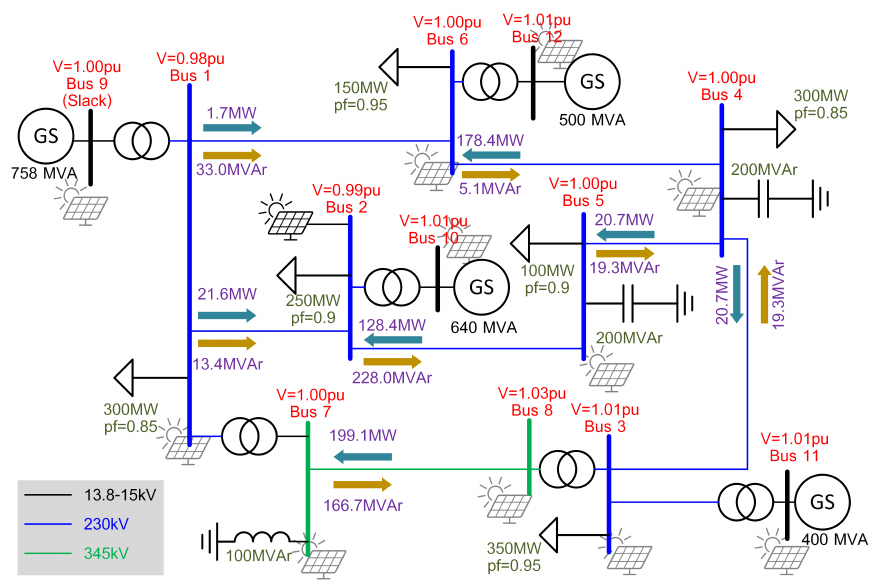
Figure 2. Single line diagram for the modified benchmark network with PV plant connected to bus 2 and values corresponding to approximately 65% (1450 MW) load level. The transmission circuit was completely assessed for PV connection at any of its